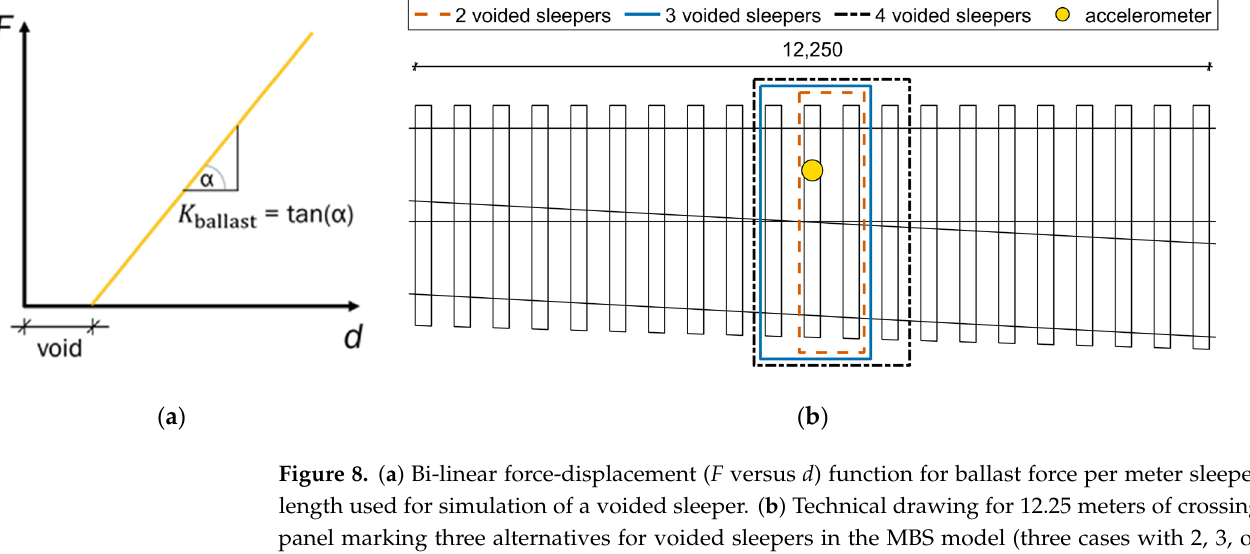
Figure 7. ( a ) MBS model of vehicle–track system, and ( b ) 2D representation of vehicle–track system during a passage through the crossing panel.